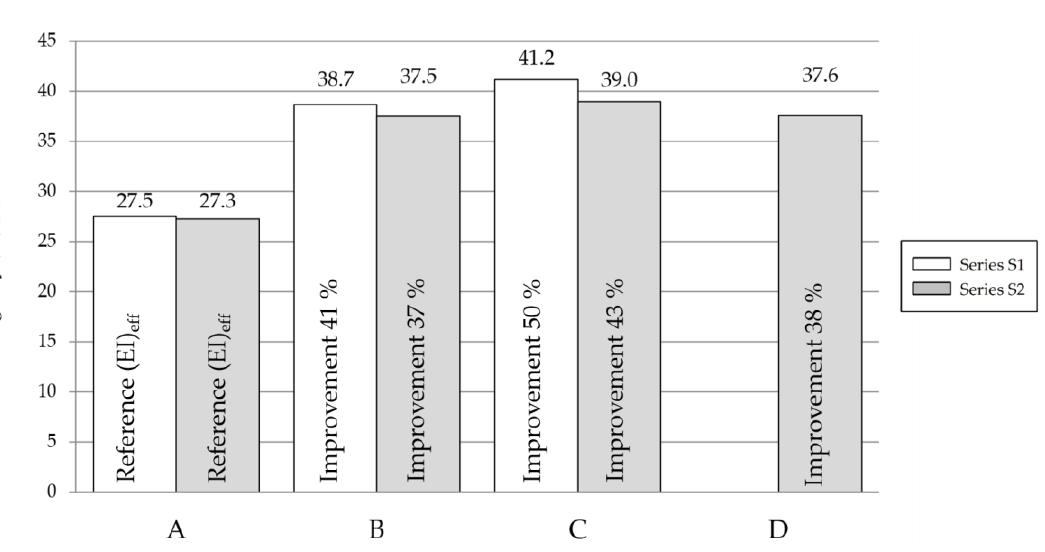
Figure 11. Effective flexural rigidity of type A, B, C, and D specimens.